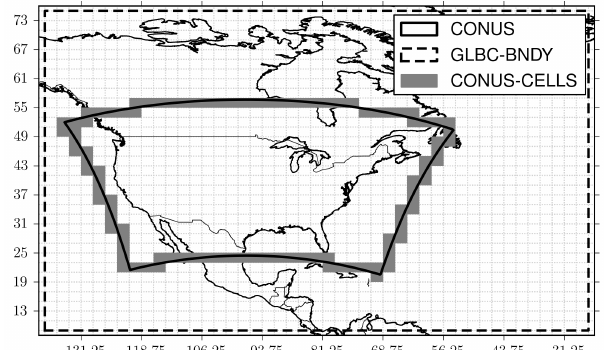
Fig. 1. GEOS-Chem lateral boundary condition output domain (GLBC; black dashed line) with the CONUS domain (black line) and grid cells that intersect the CONUS domain boundary.